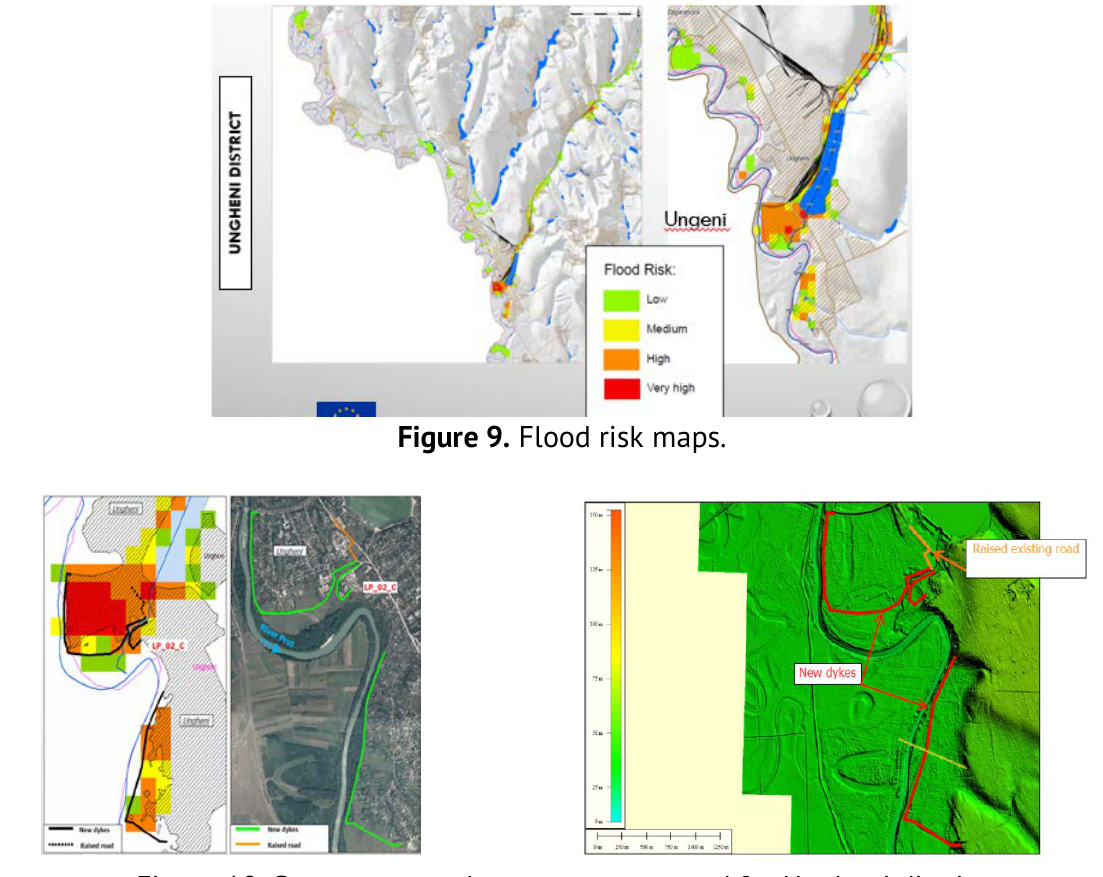
Figure 10. Some structural measures proposed for Ungheni